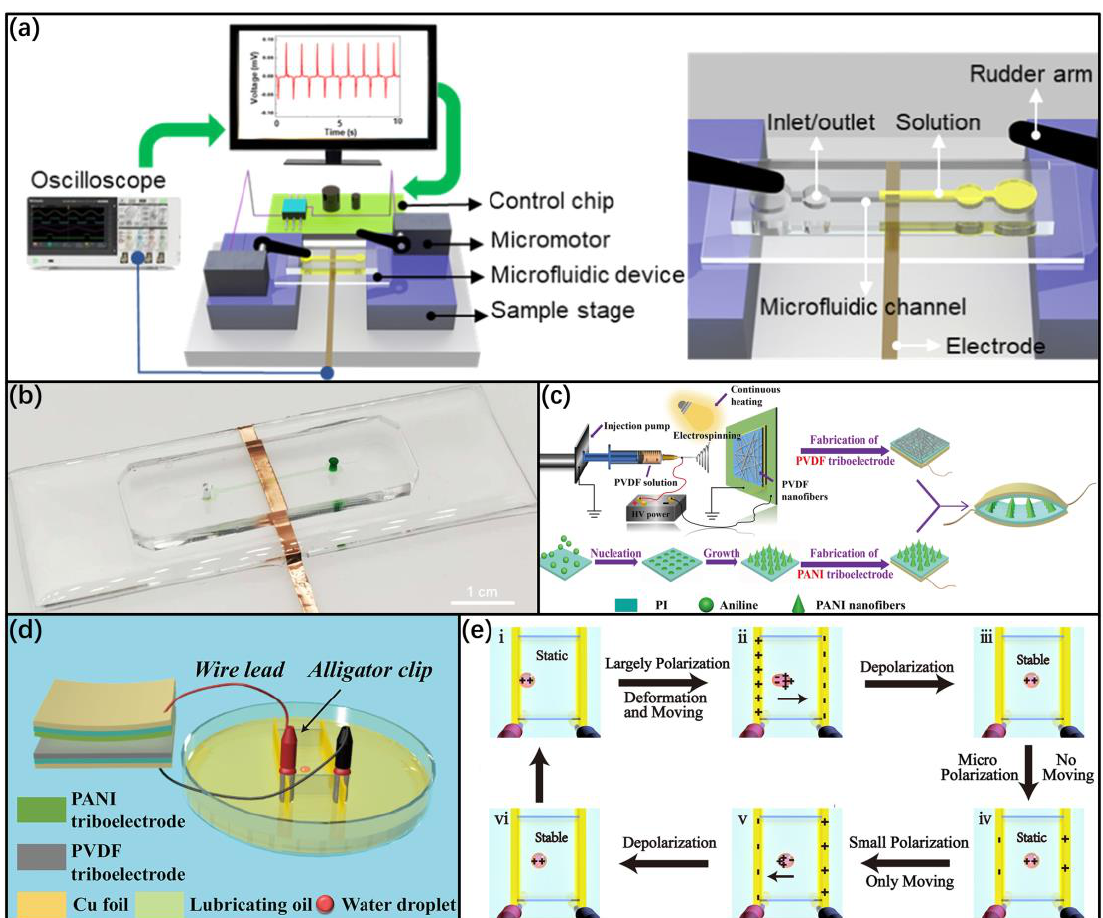
Figure 5. ( a ) Model of the system structure and ( b ) model of the microfluidics device [55]. ( c – e ) The NW-TENG and EMS system [57]. ( c ) Assembly process of NW-TENG. ( d ) The dual-motor EMS model. ( e ) The working step of the droplet-driven system.